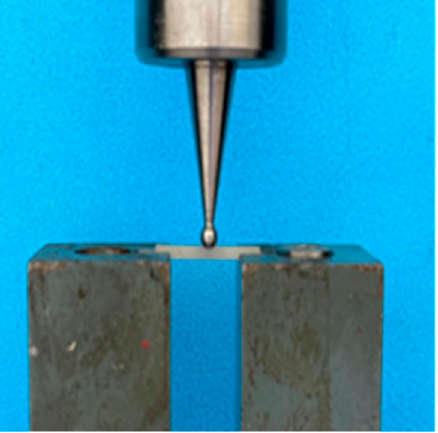
Figure 5. Placement of sample in UTM machine.